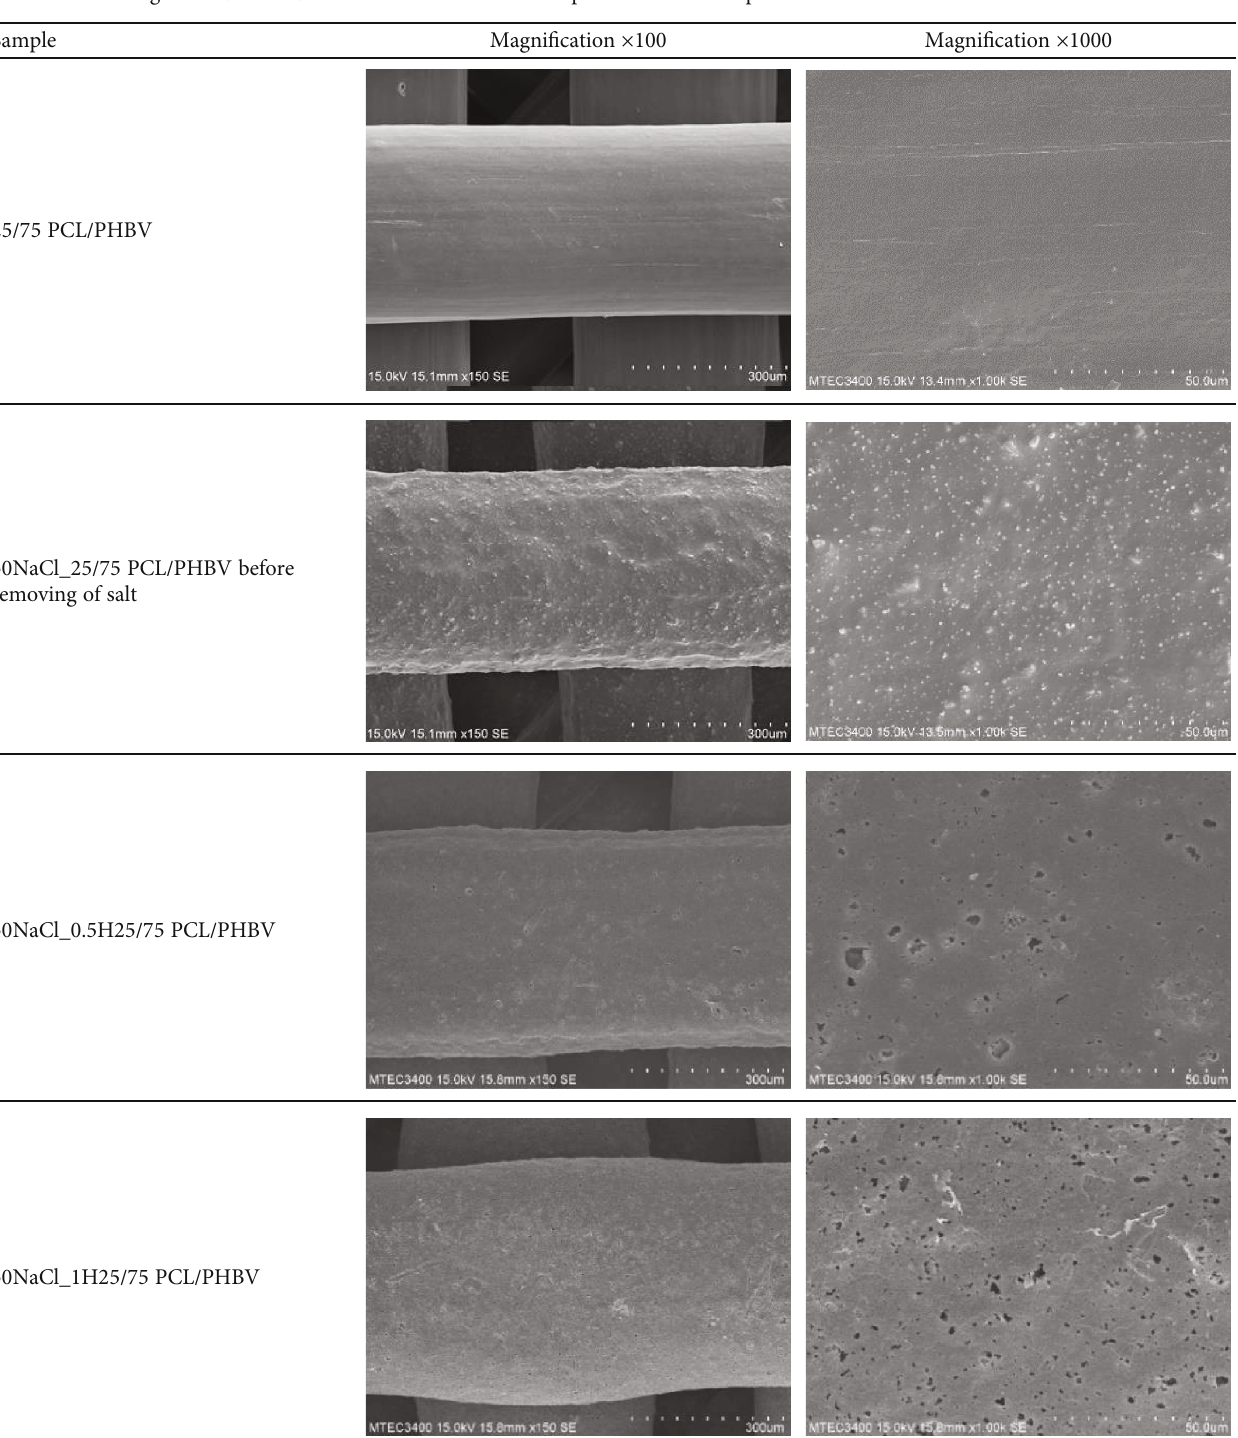
Table 4: SEM images of 25/75 PCL/PHBV sca ff olds without local pore and with local pores obtained from di ff erent concentrations of